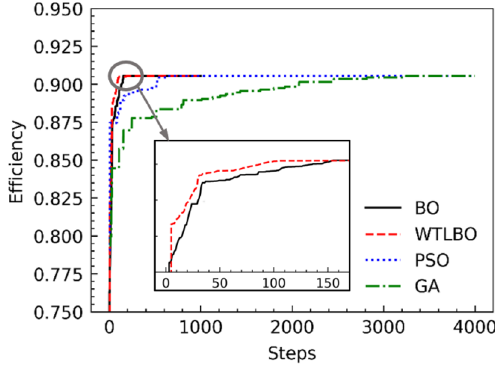
Fig. 9 Optimization results on the target task during optimization